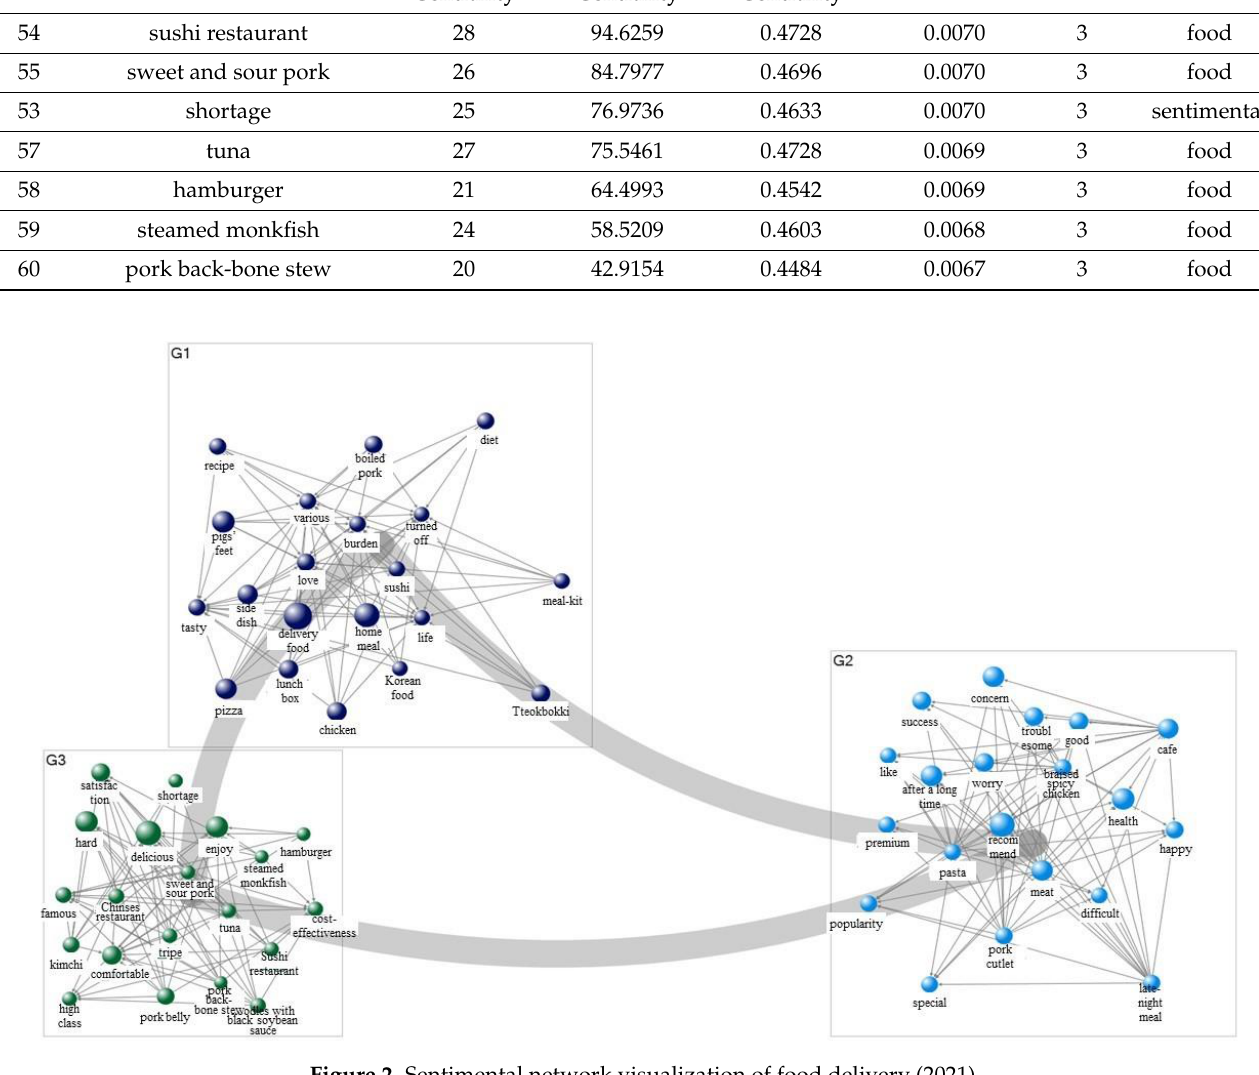
Figure 2. Sentimental network visualization of food delivery (2021). 291